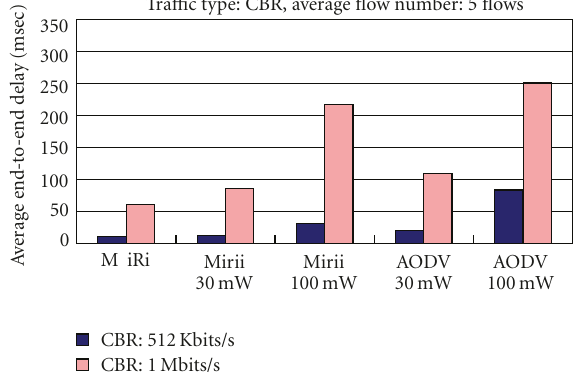
Figure 9: Average end-to-end delay of di ff erent tra ffi c load in a random network topology.